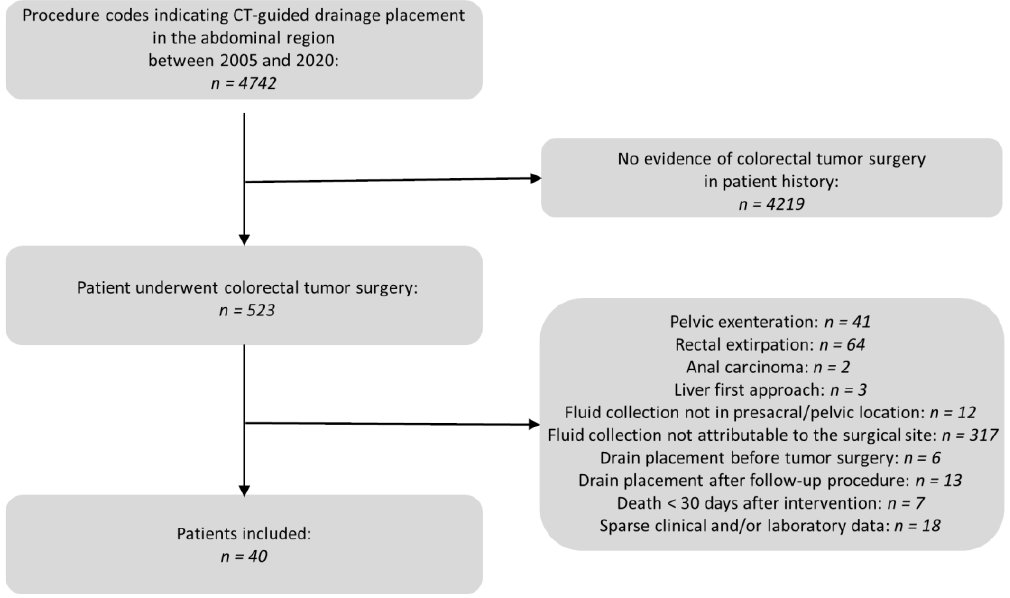
Figure 1. Flow chart of the patient selection process.